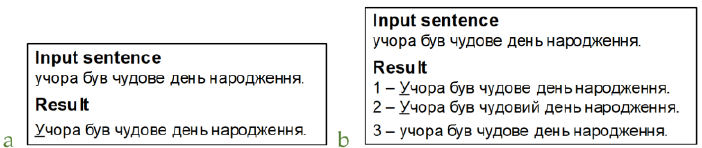
Figure 17. Wrong correction and variants of correction.